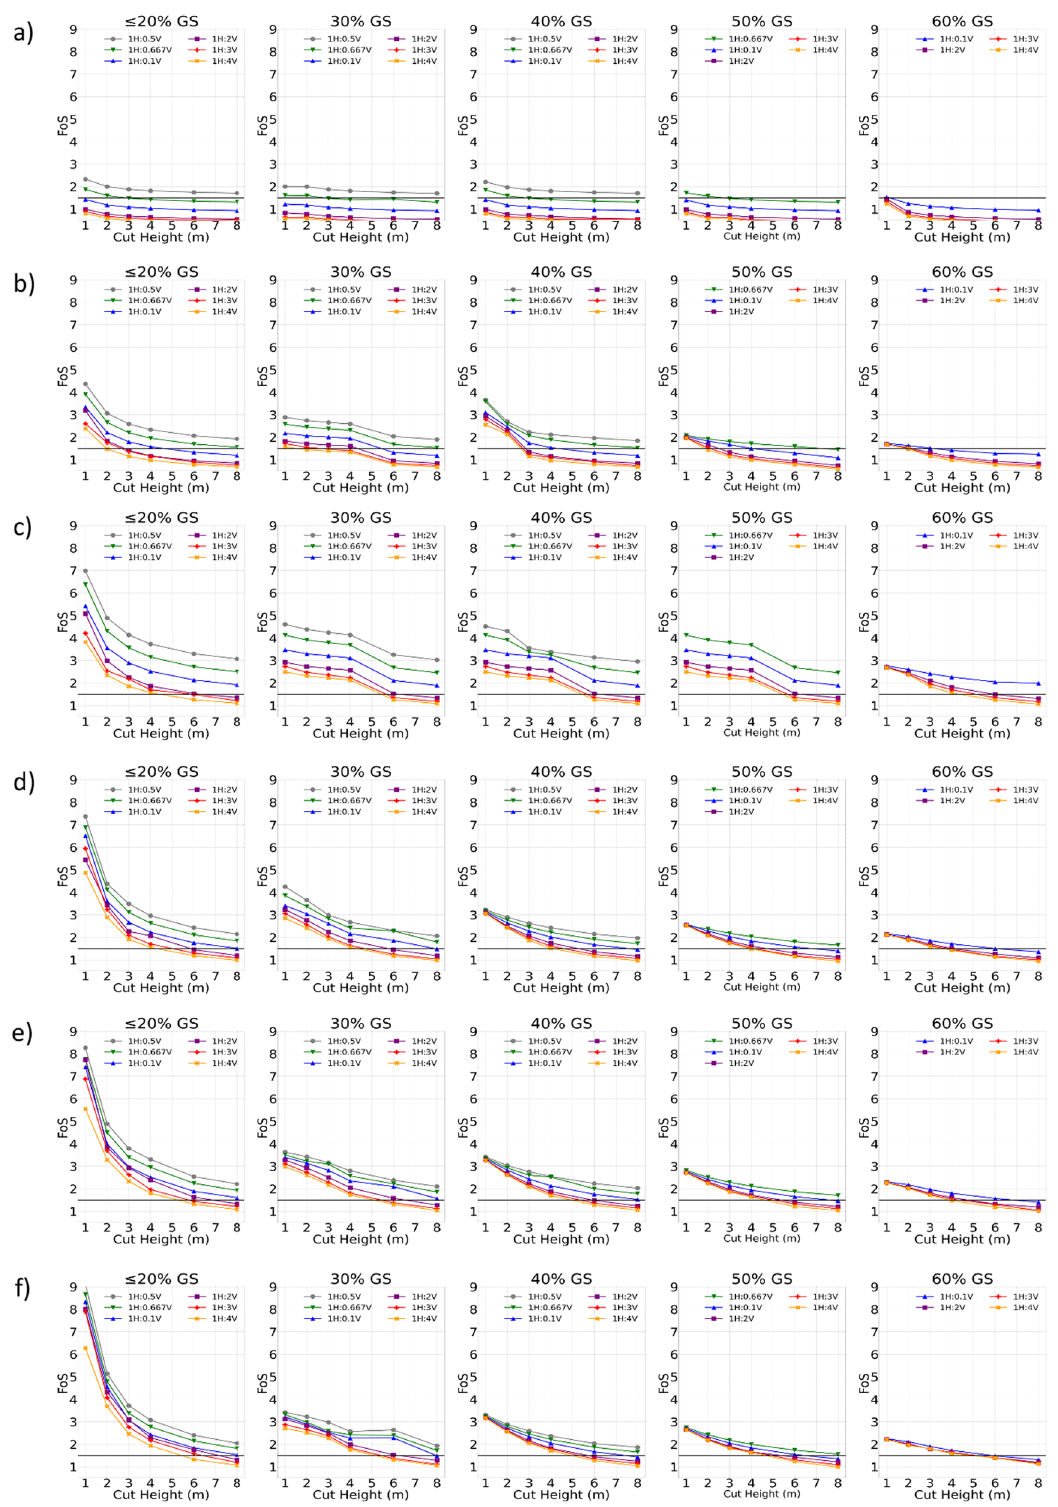
Fig. 6 Cut height v/s FoS charts for: a coarse-grained soil, b coarse-grained soil with non-plastic fines, c coarse-grained soil with plastic fines, d silt, e low plasticity clay, f high plasticity